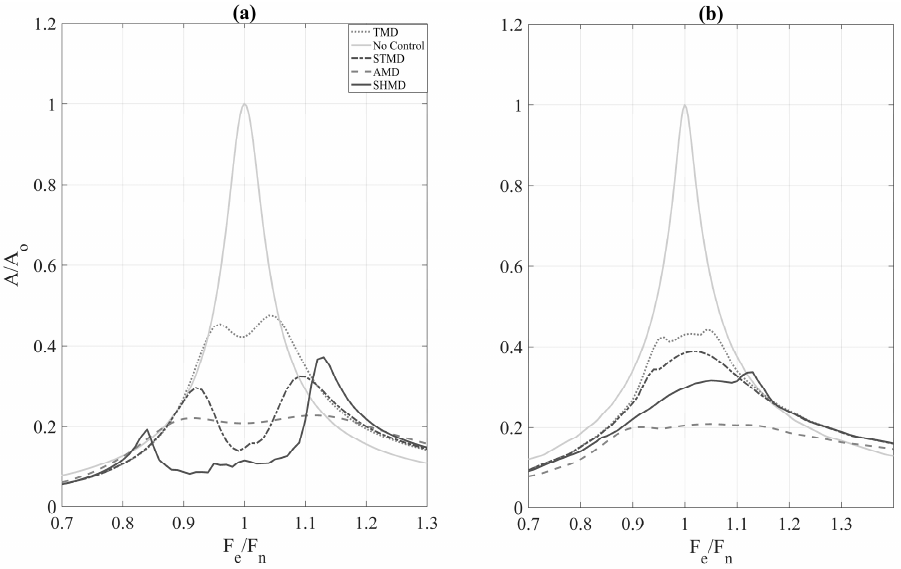
Figure 10. ( a ) Steady ‐ state; and ( b ) Peak frequency acceleration response of the different structural configurations.